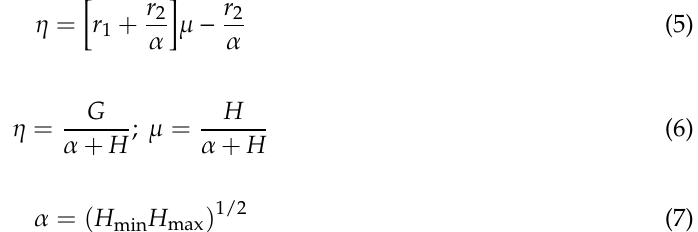
Figure 11. Kelen–Tüd ő s plot indicating variation of η vs. µ for copolymerization of EUGMA with MMA.